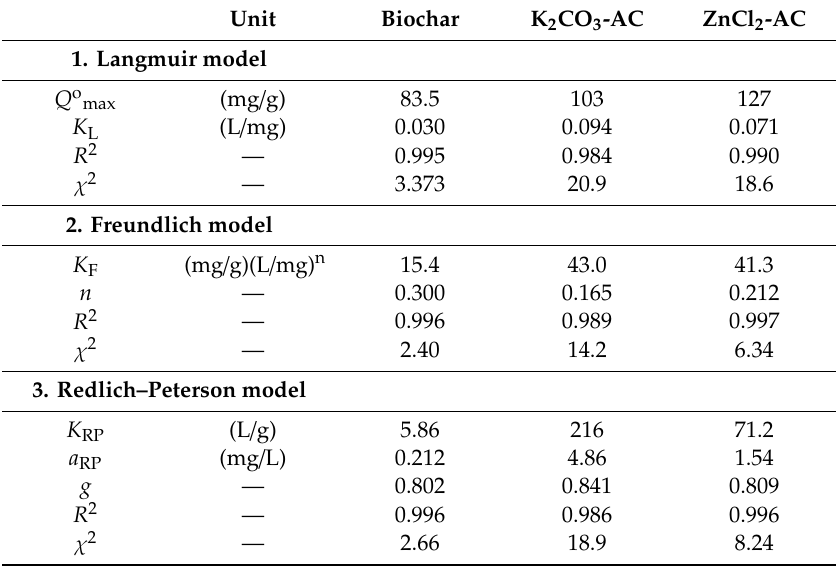
Table 2. Corresponding parameter of chromium adsorption isotherms onto the biochar and ACs. Unit